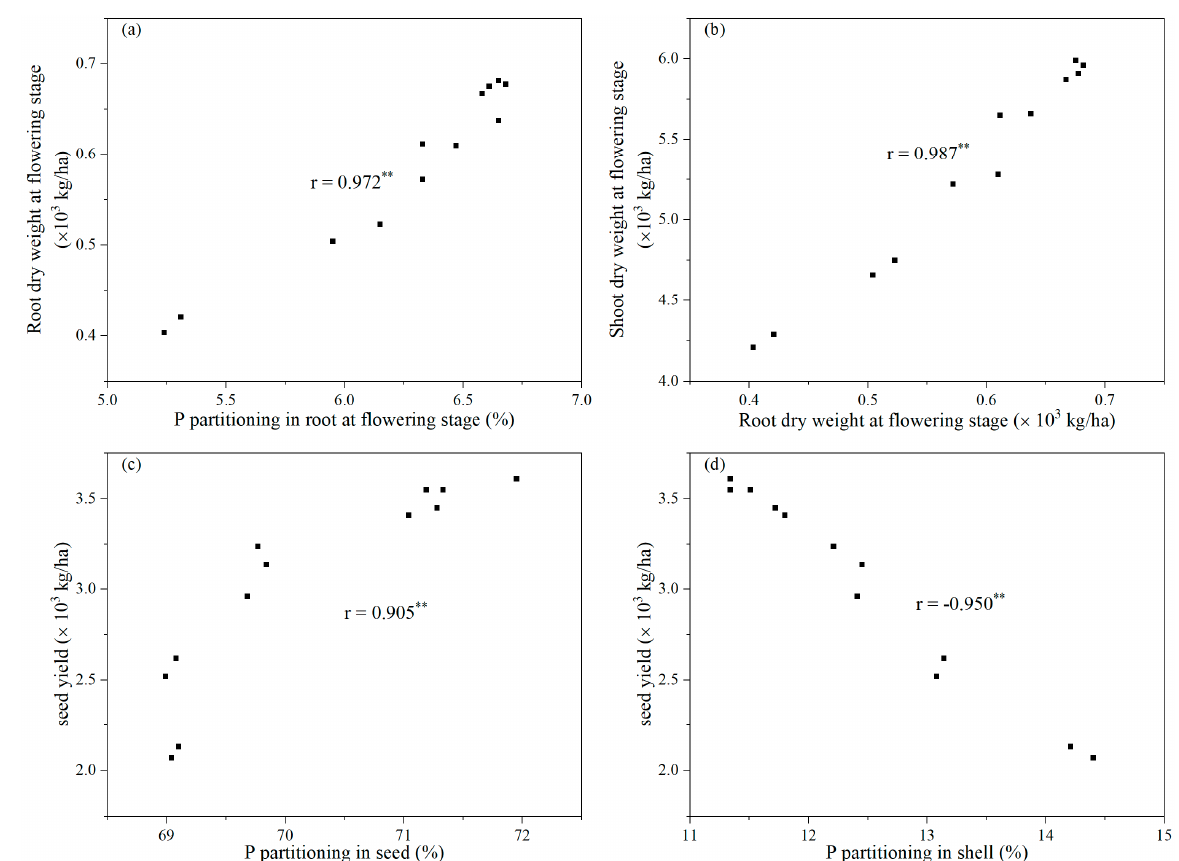
Figure 5. Correlation between some parameters in this study. ( a ): the relationship between P partitioning in root, and root dry weight, at the flowering stage. ( b ): the relationship between root dry weight and shoot dry weight (stem and leaf) at the flowering stage. ( c ): the relationship between P partitioning in seed and seed yield. ( d ): the relationship between P partitioning in shell and seed yield. ** p < 0.01.